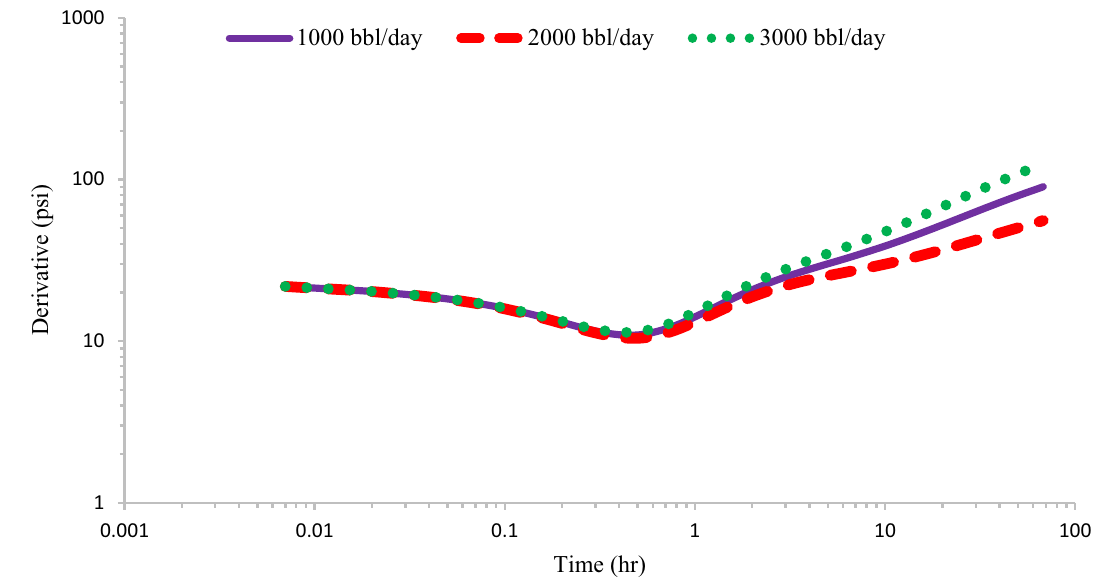
Fig. 17 Sensitivity analysis of scenario No. 6 on the rate and time production of the adjacent well in naturally fractured reservoir